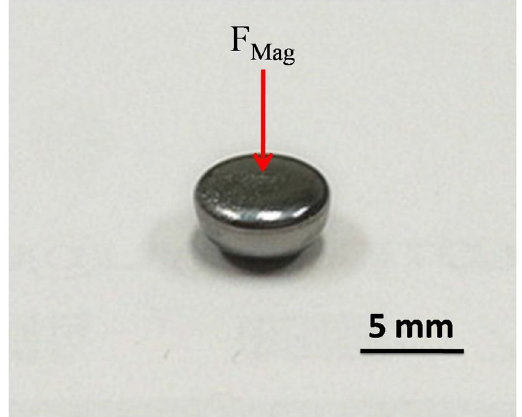
Figure 8. Image of the sample solidified in strong gradient magnetic field of Co 76 Sn 24 alloy.